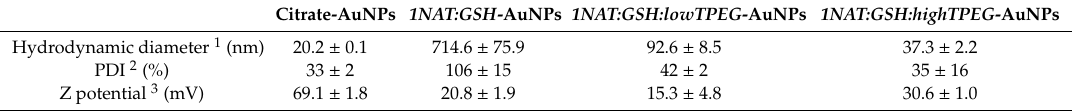
Table 2. Physicochemical Characterization of the multifunctional AuNPs